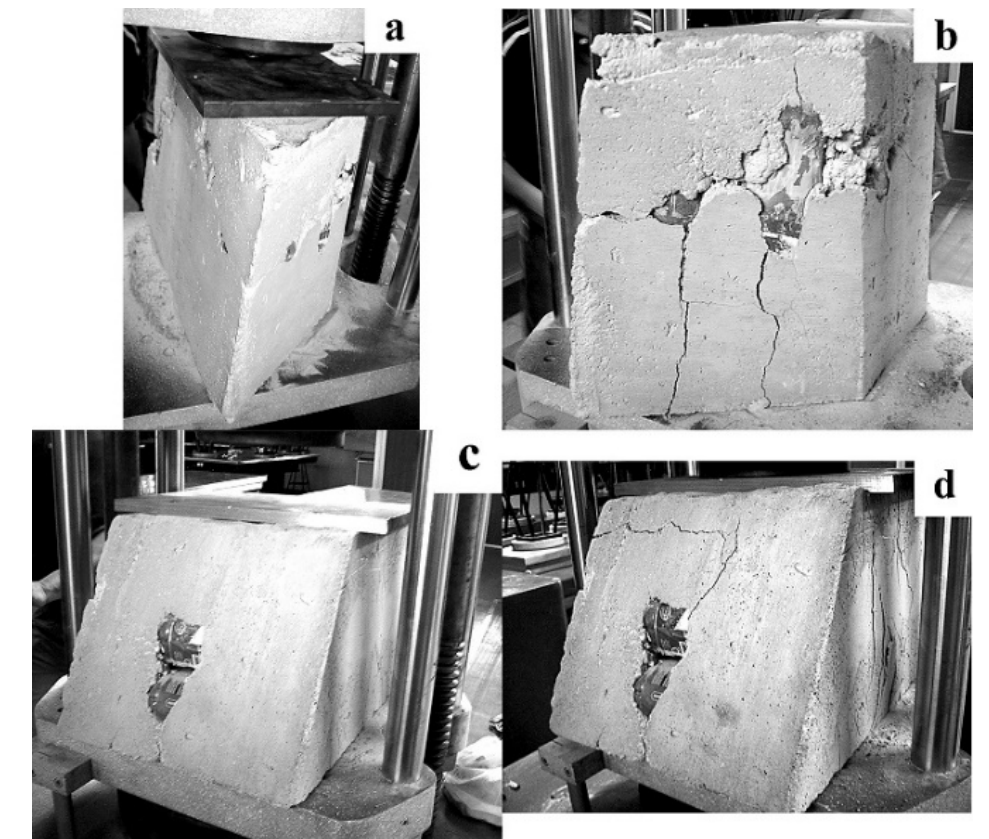
Figure 4. ( a ) Trapezoidal block with bottles in the vertical position; ( b ) upright block after compression; ( c ) trapezoidal block with bottles in the horizontal position; ( d ) recumbent block after compression.